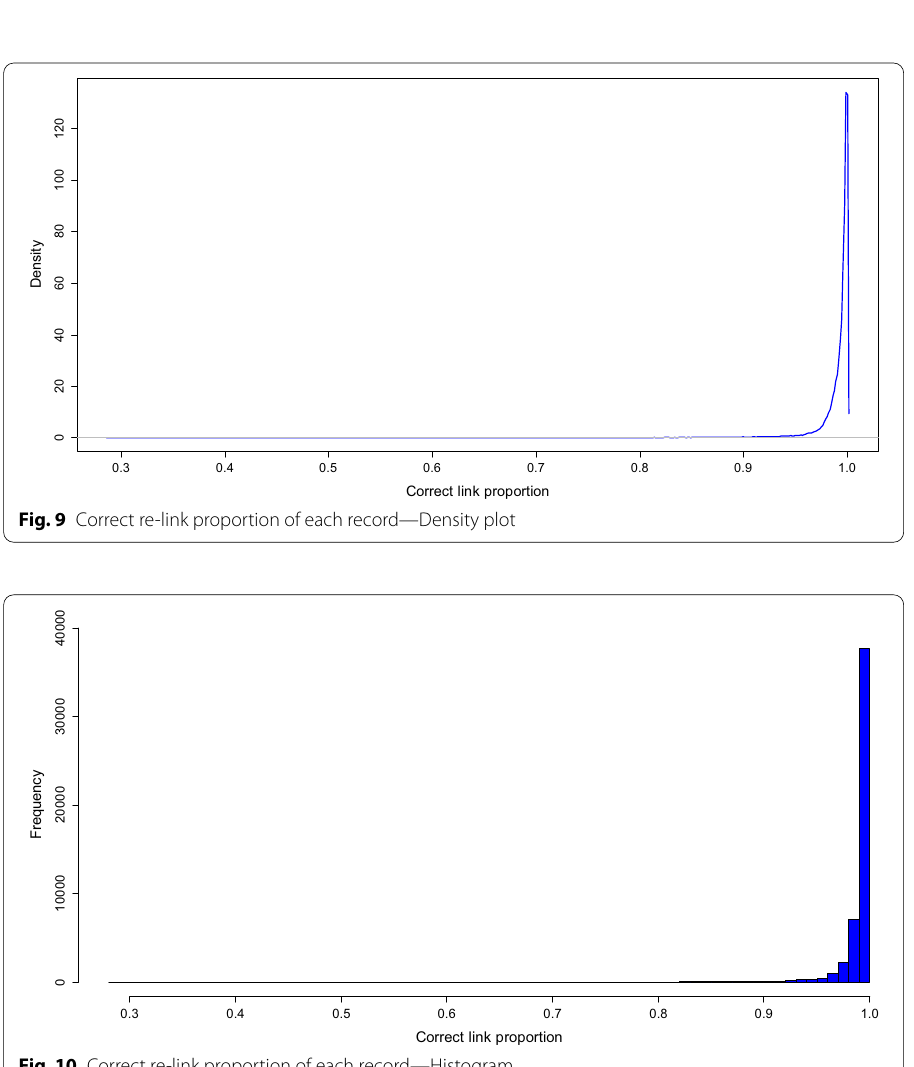
Fig. 10 Correct re-link proportion of each